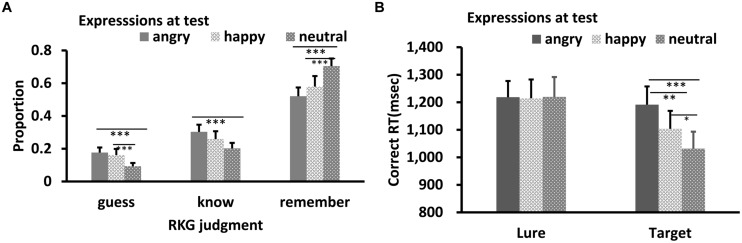
RKG judgment (A) and Correct RT (B) as a function of test expression (Experiment 1). Error bars represent 1 SEM. ∗p < 0.05; ∗∗p < 0.01; ∗∗∗p < 0.001.